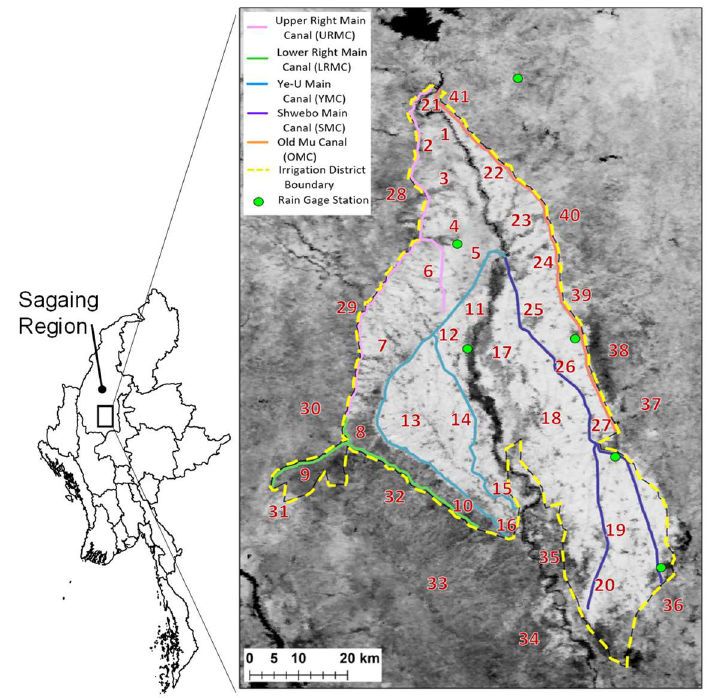
Figure 1. Study area and the locations of sample points indicated by number depicted on MODIS